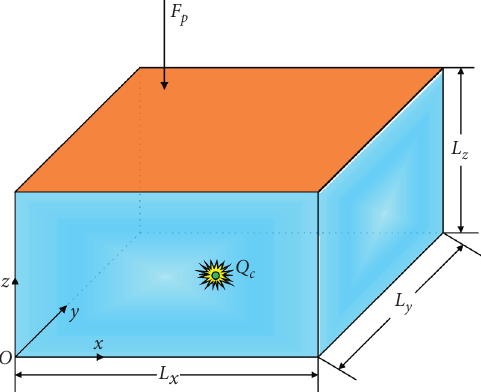
Figure 1: Schematic of the considered flexible plate strongly coupled with a rectangular